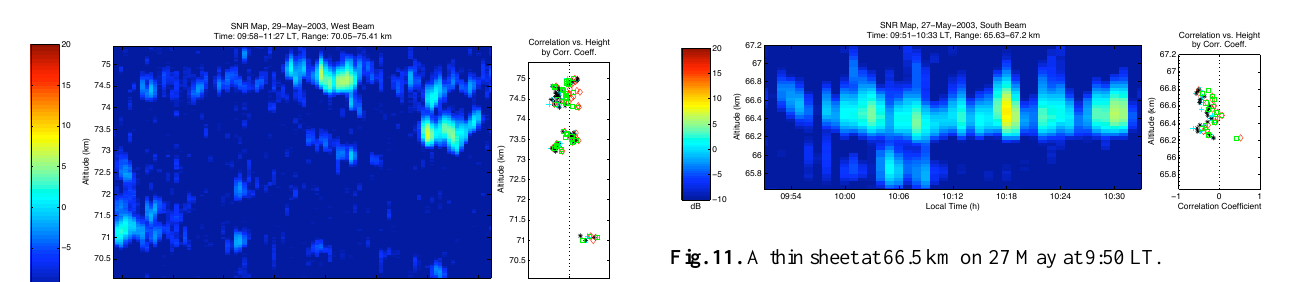
Fig. 14. A thin sheet at 64 km on July 14, 2004, at 13:15 LT.